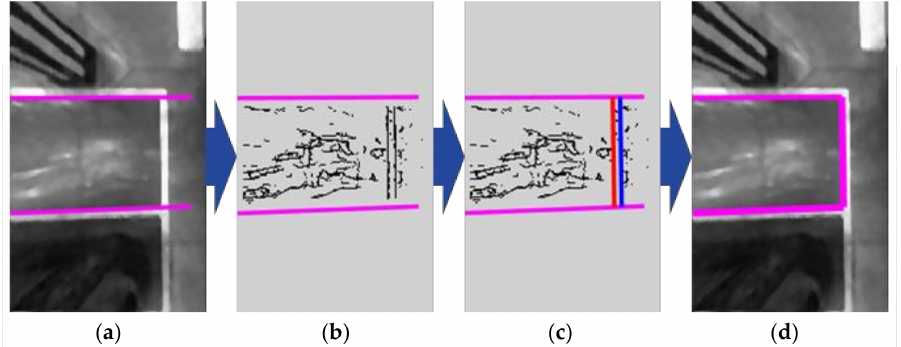
Figure 9. Line-based entrance detection procedure. ( a ) Separating line pair constituting a parking slot candidate; ( b ) Edge pixels between two separating lines; ( c ) RANSAC-based parallel line pair detection result; ( d ) Completely recognized parking